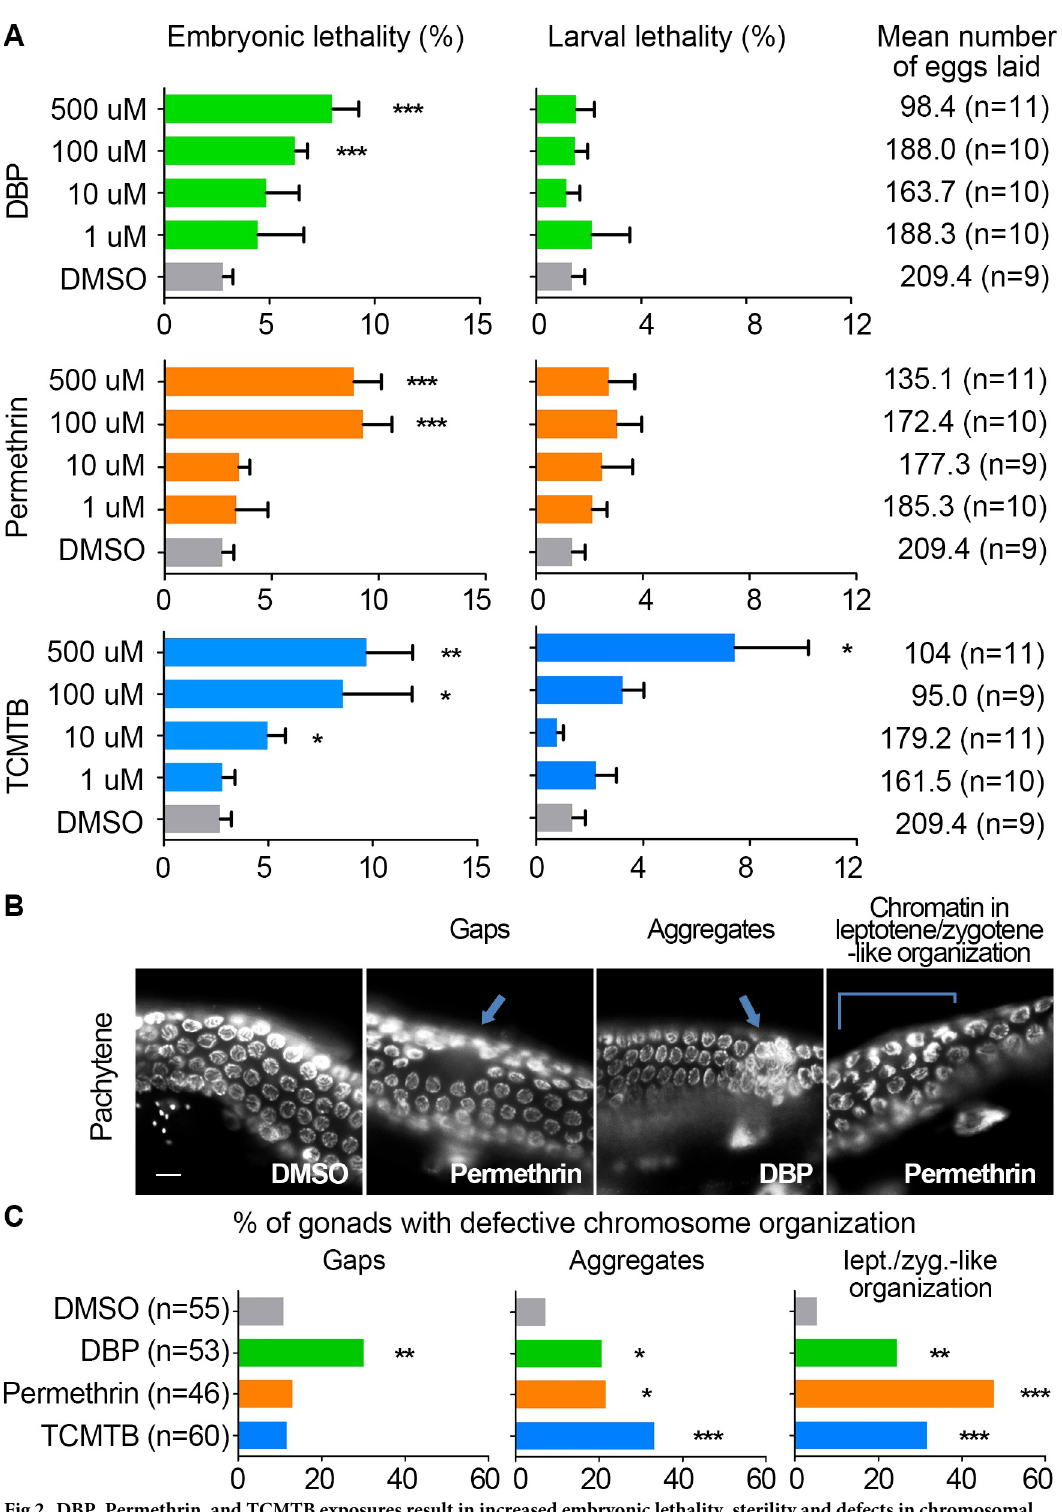
Fig 2. DBP, Permethrin, and TCMTB exposures result in increased embryonic lethality, sterility and defects in chromosomal organization in the germline. (A) Plate phenotypes for indicated chemical exposures. Embryonic lethality, larval lethality and the number of eggs laid (brood size) are shown for the indicated doses of exposures and compared to vehicle alone (0.1% DMSO). Error bars represent SEM. � P < 0.05, �� P < 0.01, and ��� P < 0.001 by the two-tailed Mann-Whitney test, 95% C.I. (B) Images show pachytene